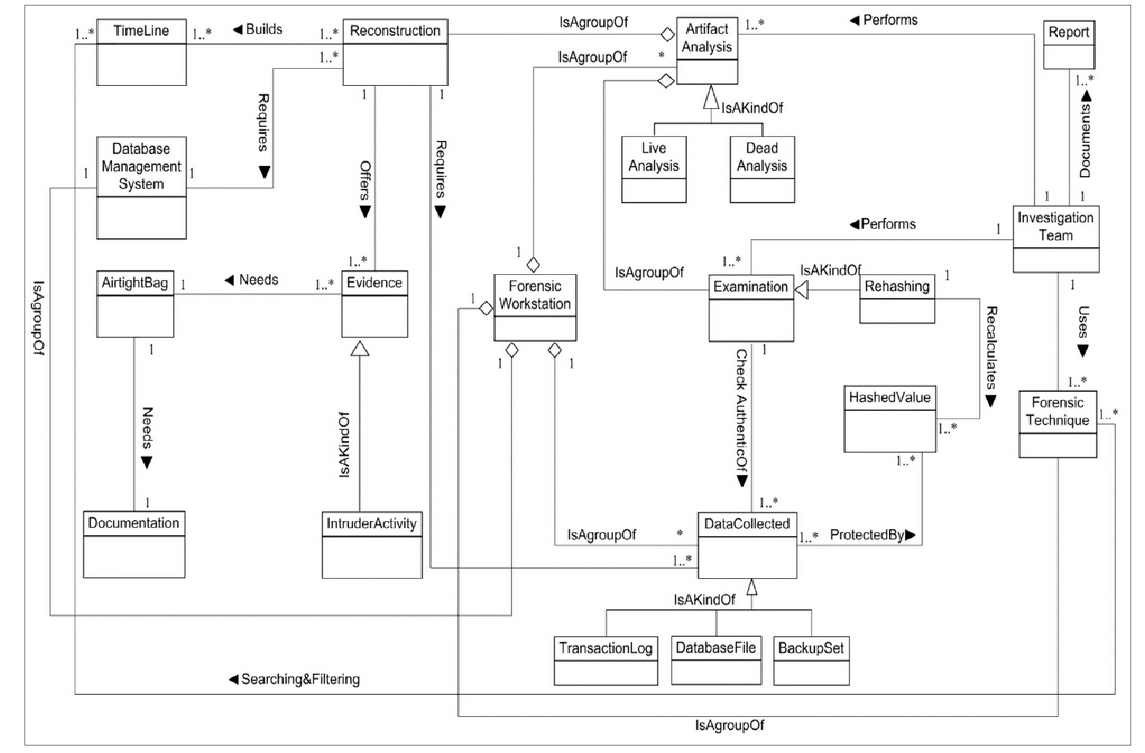
Figure 3. DBFIM artifact analysis (Class 3).